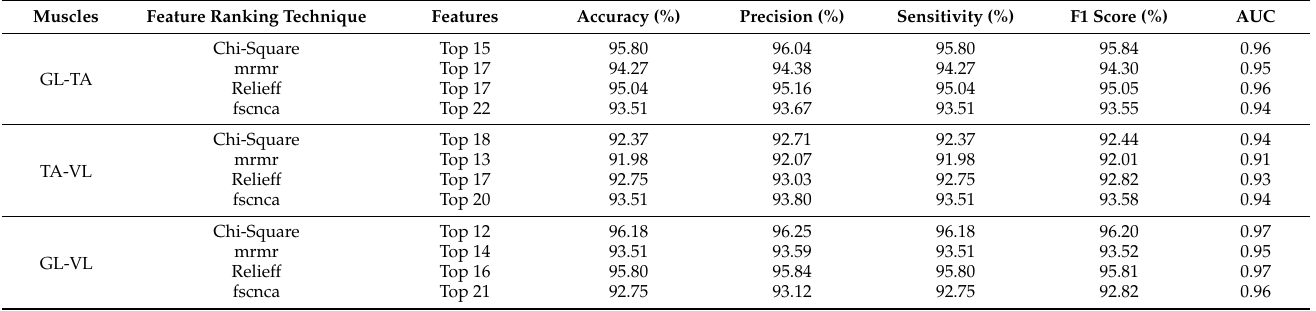
Figure 4. Top-ranked features from the GL muscle EMG signal by ( a ) Chi-Square, ( b ) mrmr, ( c ) Relieff, ( d ) fscnca feature selection techniques. Table 4. Evaluation matrix for two-channel analysis for EMG data using different feature selection techniques.